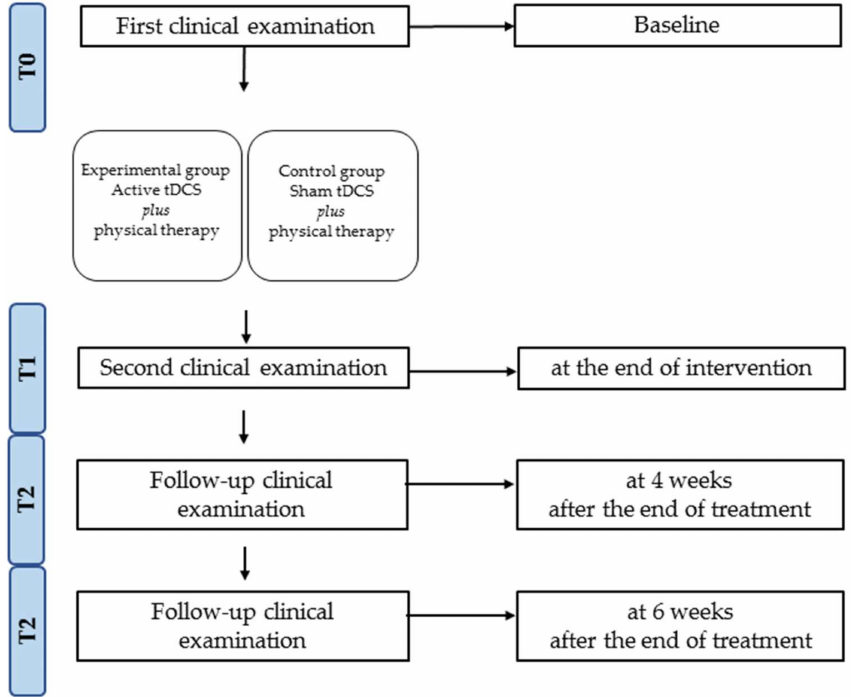
Figure 1. Study design and